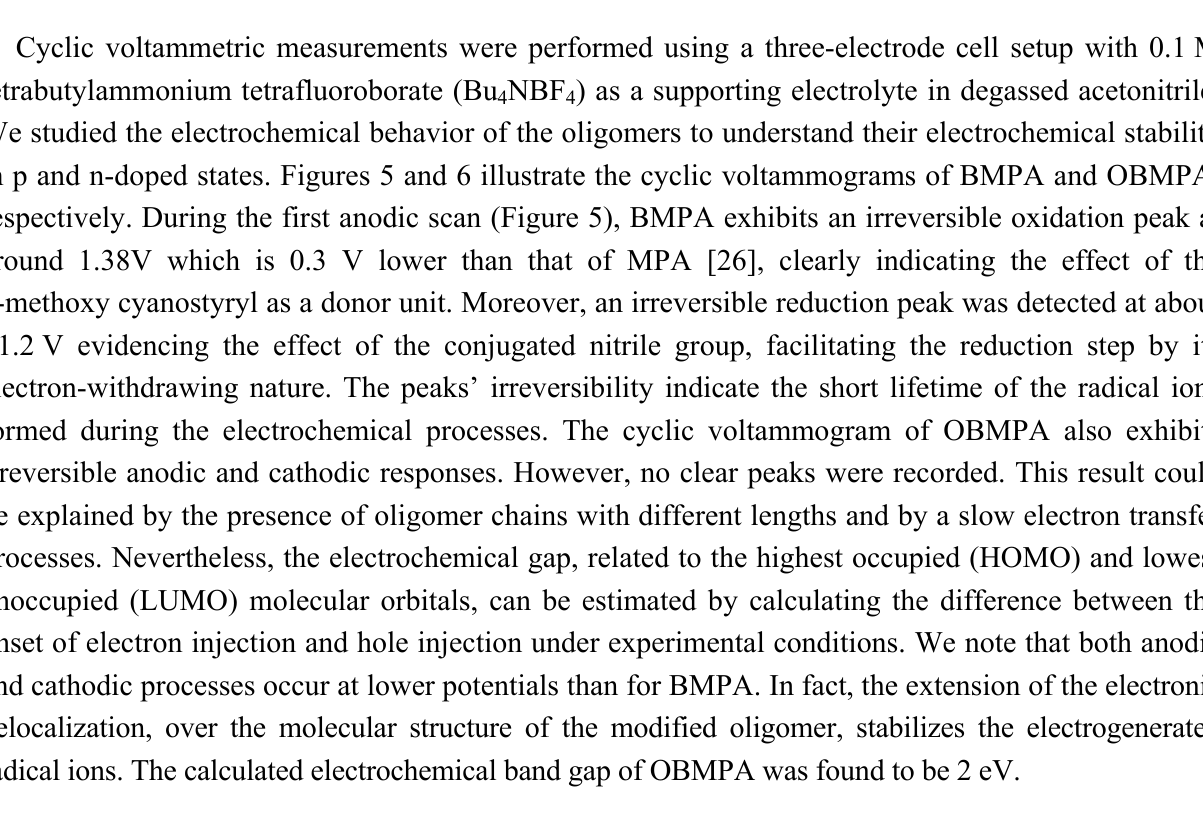
Figure 5. Oxidation and reduction voltammogram of BMPA performed in